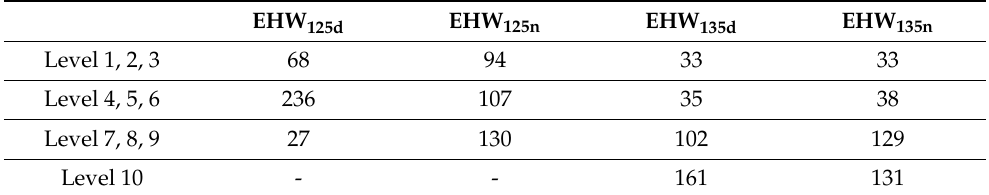
Figure 3. Spatial distribution maps of EHW 125d , EHW 125n , EHW 135d , and EHW 135n in Beijing with a resolution of 1 km. (EHWn represents EHW 125d , EHW 125n , EHW 135d , or EHW 135n ). Table 1. The number of townships that belong to the cumulative hours of extreme heat waves at different levels.